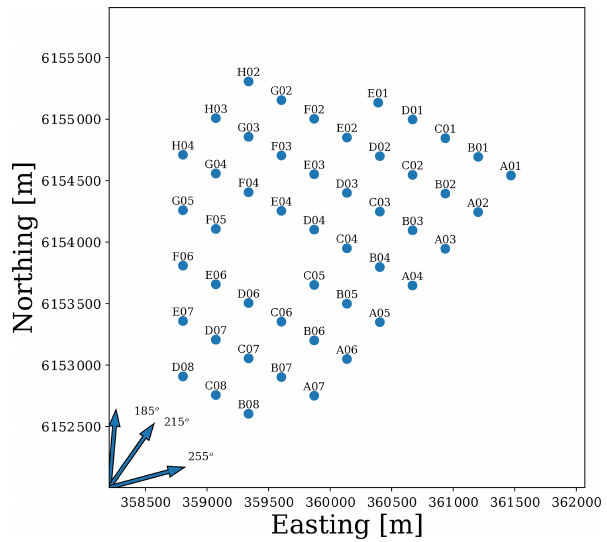
Figure 4. Layout of the Lillgrund wind plant with wind direction used in each